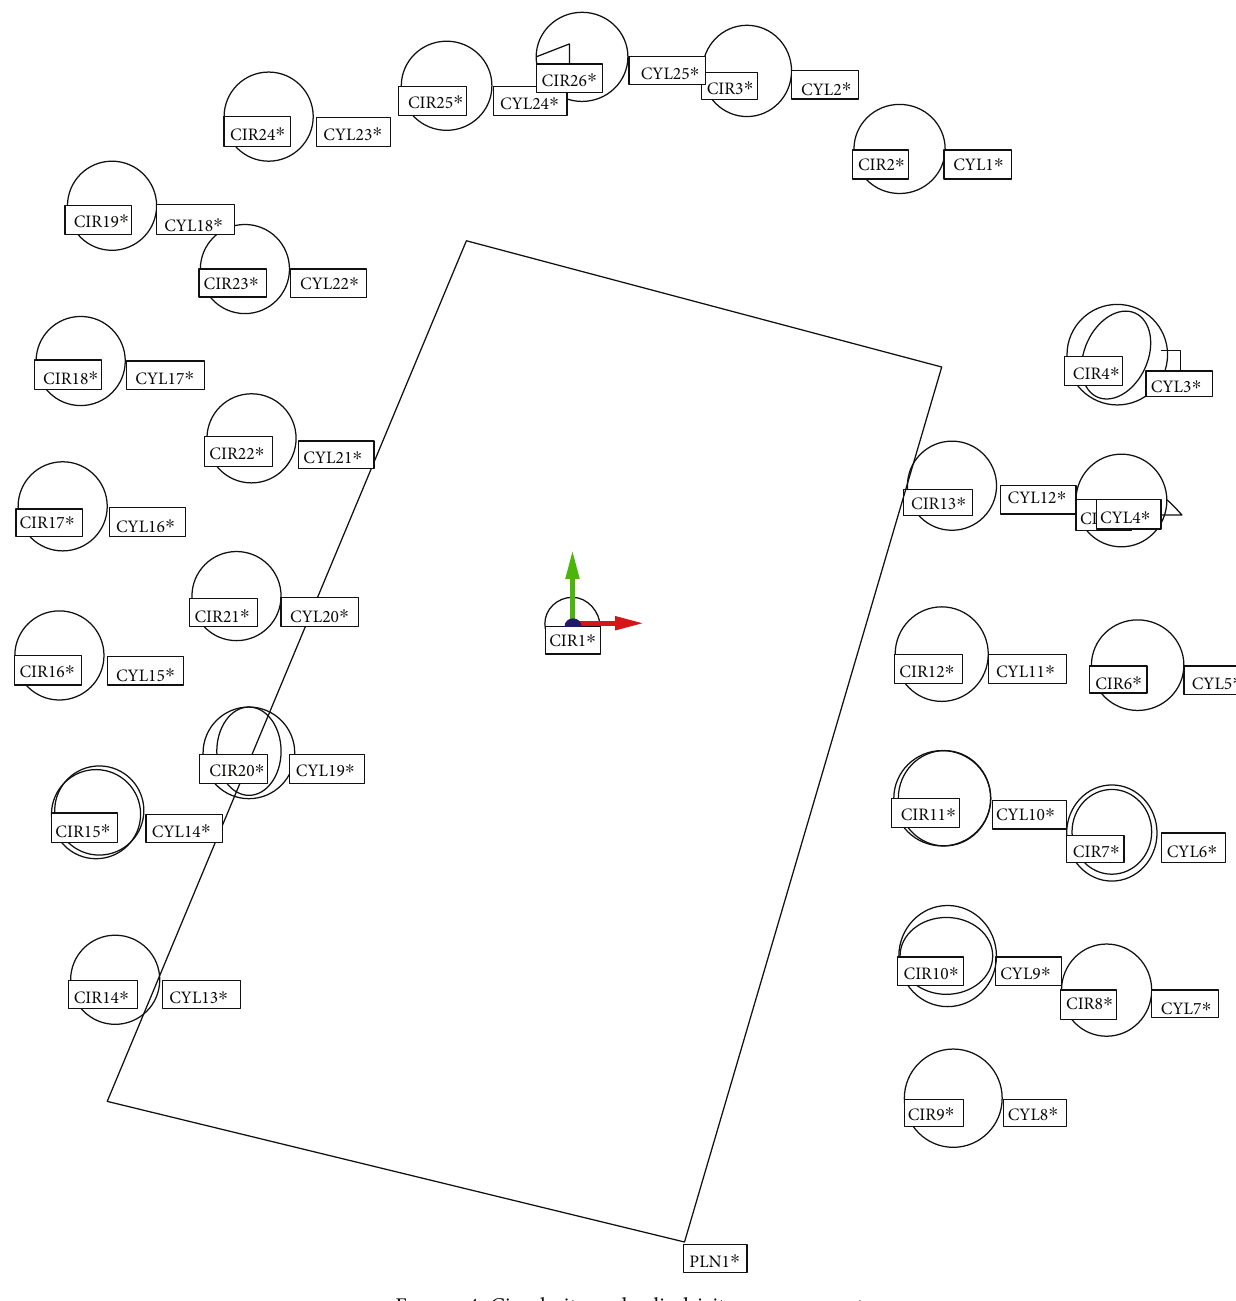
Figure 4: Circularity and cylindricity